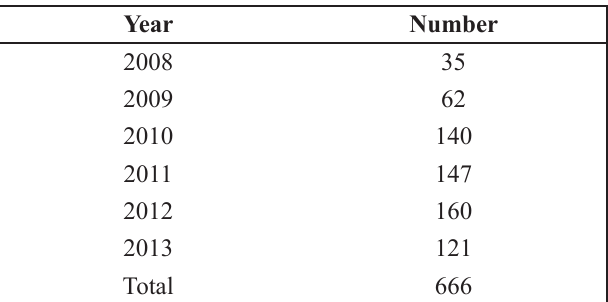
Table 1. Suicide rates in the various years of the period 2008- 2013 according to emergency unit records of Shahid